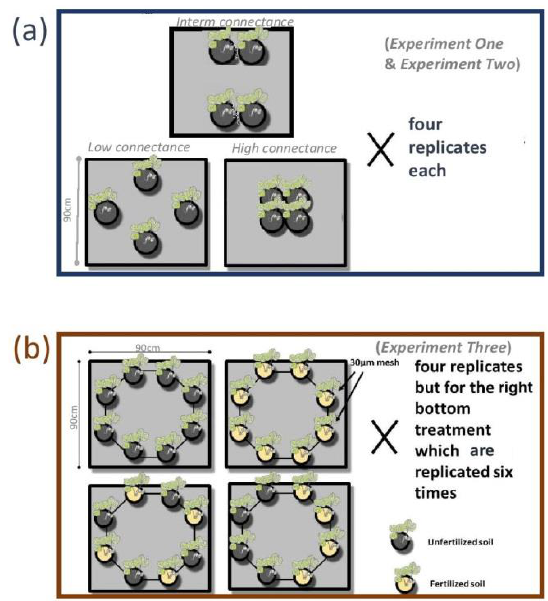
Figure 1. Schematic representation of the experimental design of the three experiments. ( a ) In Experiment One and Experiment Two we manipulated the connectance (low; intermediate and high) of four vegetated inserts (dark grey) over an unvegetated soil (sterilized and diluted with sand) matrix (in light grey). In Experiment One we used Plantago lanceolata as a host whereas in Experiment Two Medicago lupulina . ( b ) In Experiment Three we manipulated the diversity (i.e., only one habitat type; either fertilized or unfertilized or both habitat types) and spatial structure (overdispersed vs. aggregated in the bottom two subpanels) of the vegetated inserts which we describe earlier (Top and bottom left archipelagos/treatments: 4 replicates/were each replicated four times; bottom right archipelagos/treatment: six replicates/ was replicated six times).We used Medicago lupulina as a host and the matrix soil was (like in the other experiments) sterilized, mixed with sand and was kept unvegetated (light grey).